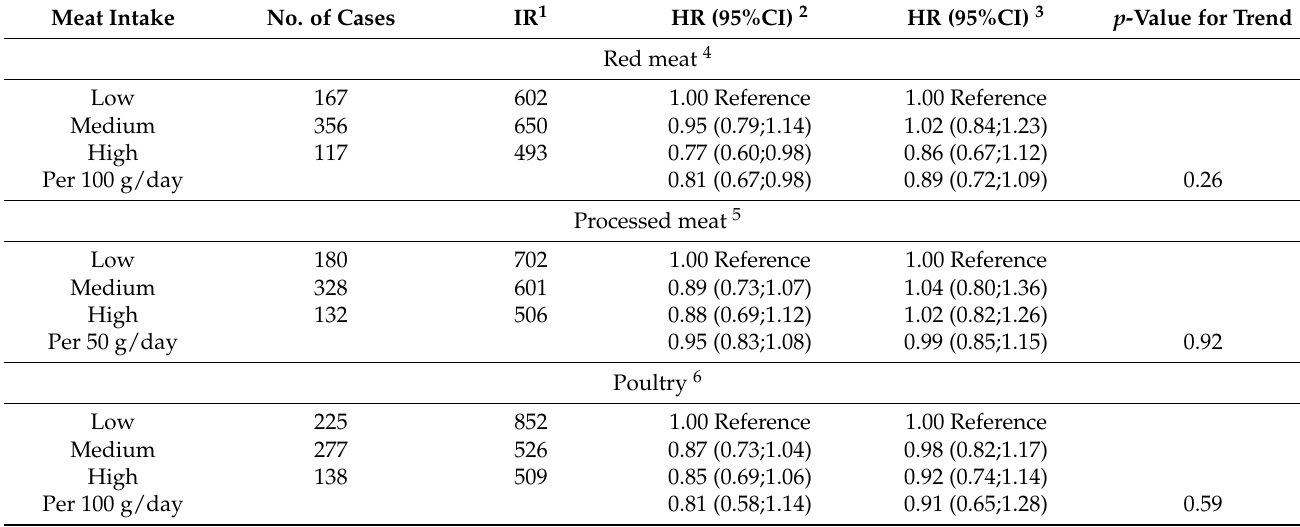
Table 4. Association between intake of different types of meat and risk of all-cause mortality, n = 9848.